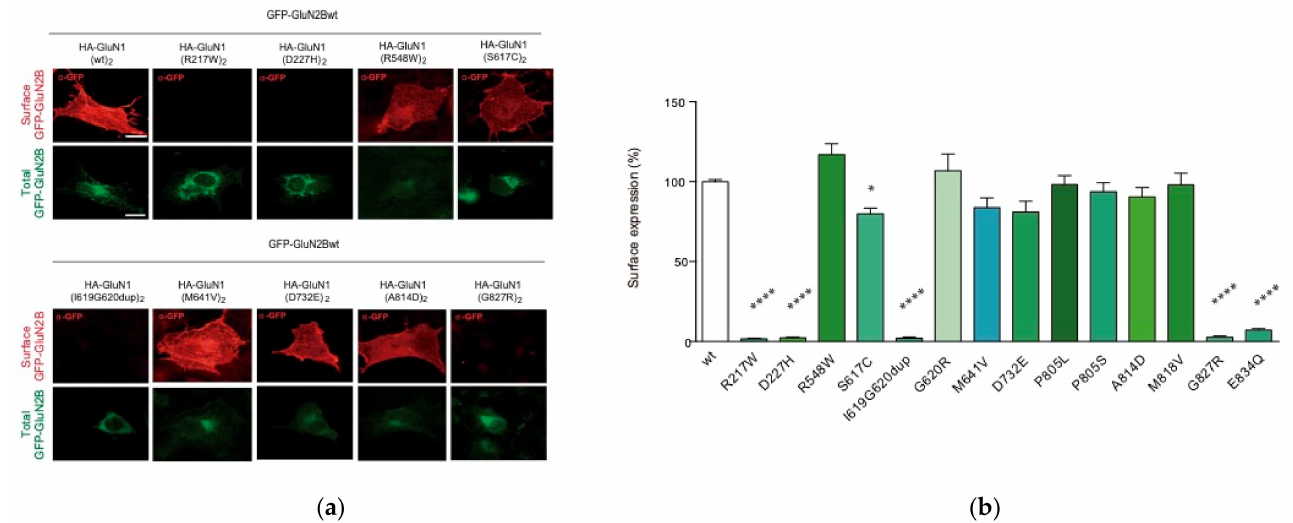
Figure 3. Effects of biallelic GRIN1 -DNVs on NMDAR surface expression. ( a ) Immunofluorescence analysis of NMDAR surface expression in COS-7 cell line co-transfected with GFP- Grin2b and HA- Grin1 (wildtype and/or mutant) constructs; scale bar: 10 µ m; ( b ) Bar graph representing the mean ± SEM of cell surface expression of NMDAR (N = 16–38 cells per condition, from 3 to 4 independent experiments; ns p -value > 0.05; * p -value < 0.05; **** p -value < 0.0001, one-way ANOVA with Bonferroni’s post hoc